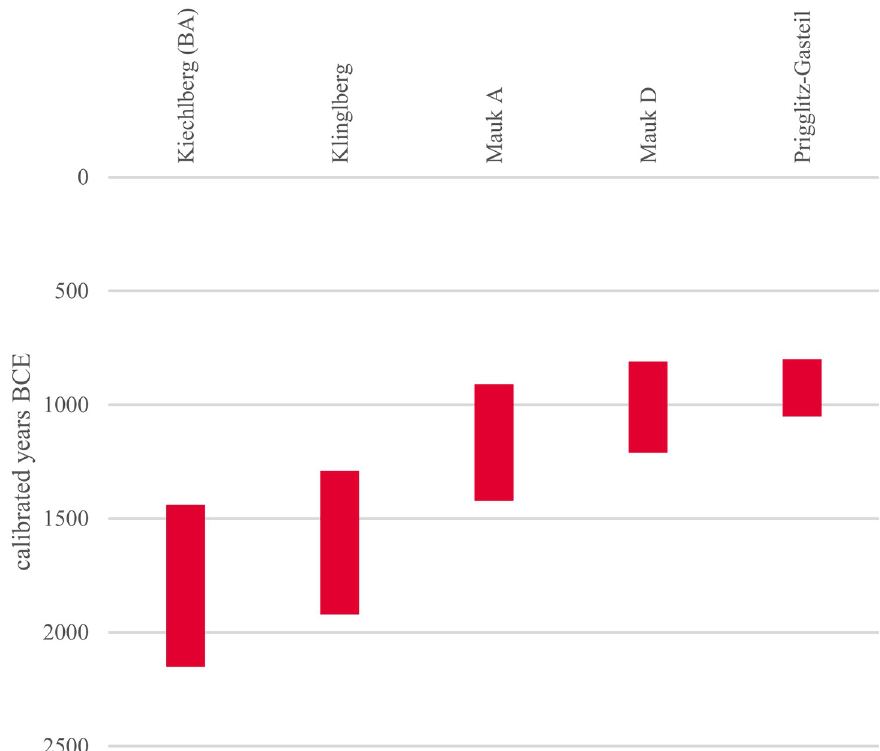
Fig 1. Rough temporal ranges of the archaeobotanically investigated Bronze Age mining sites referred to in this paper. The overview is based on the 2 σ ranges of the oldest and youngest calibrated radiocarbon dates, respectively. Intra-site modelling was only considered for Prigglitz (see section 2.3.2). Published data from Kiechlberg [17], Klinglberg [26], and Mauken [27] were recalibrated with OxCal 3.10 [28] and the IntCal13 calibration curve [29]. Illustration: OeAW-OeAI/A. G.